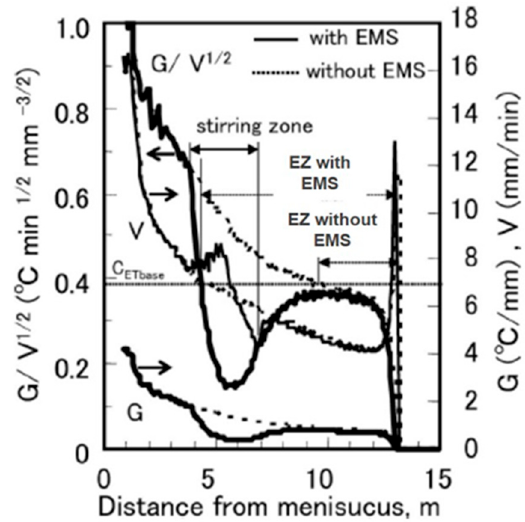
Figure 25. Effect of strand EMS on temperature gradient, dendrite tip velocity, and location of Equiaxed Zone (EZ) [146].